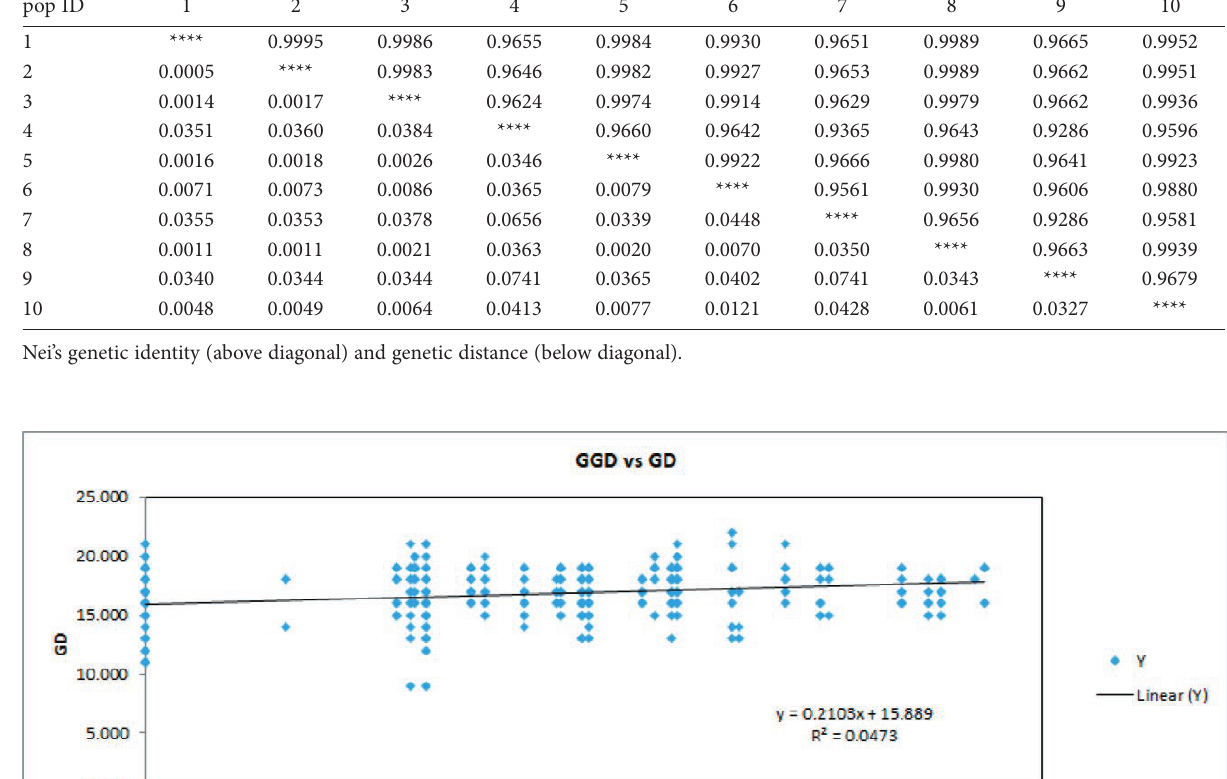
Table 4. Nei genetic identity versus genetic distance among rice geographical populations studied. pop ID